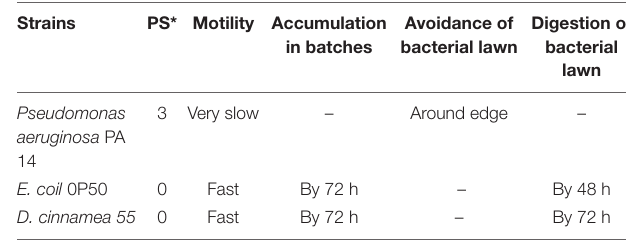
TABLE 3 | Pathogenicity score and behavioral response of C. elegans to the bacterial